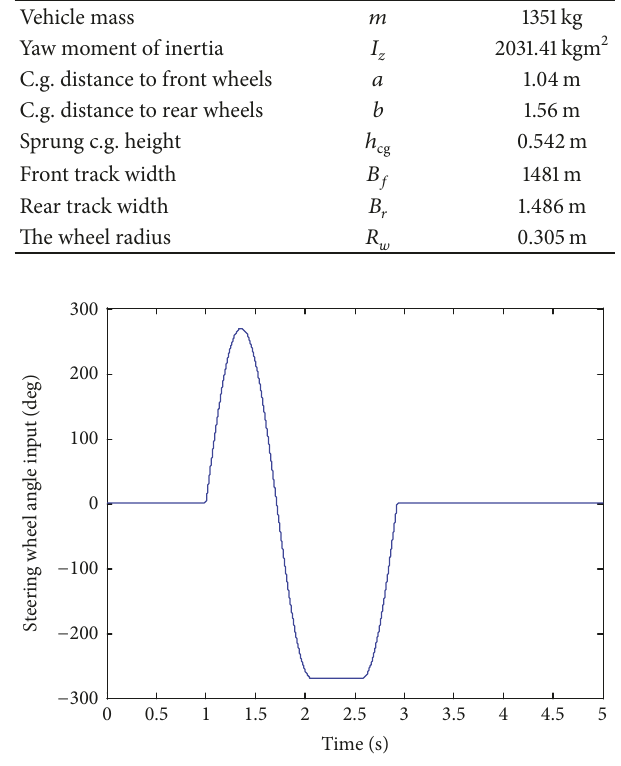
Figure 7: Sine-with-dwell steering wheel